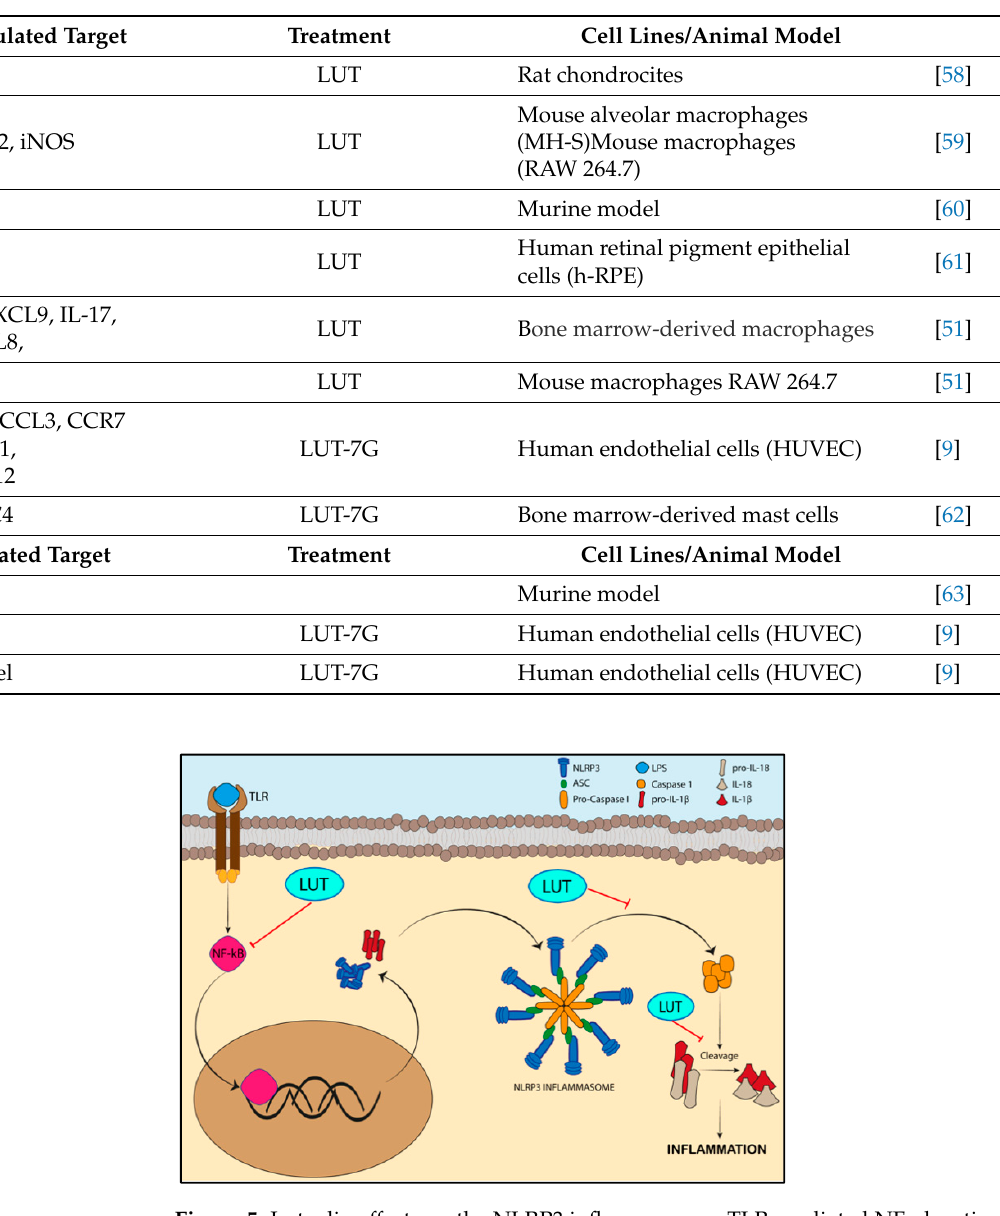
Table 6. Summary of luteolin and LUT-7G effects in regulating pro-inflammatory and anti-inflam- matory mediators.